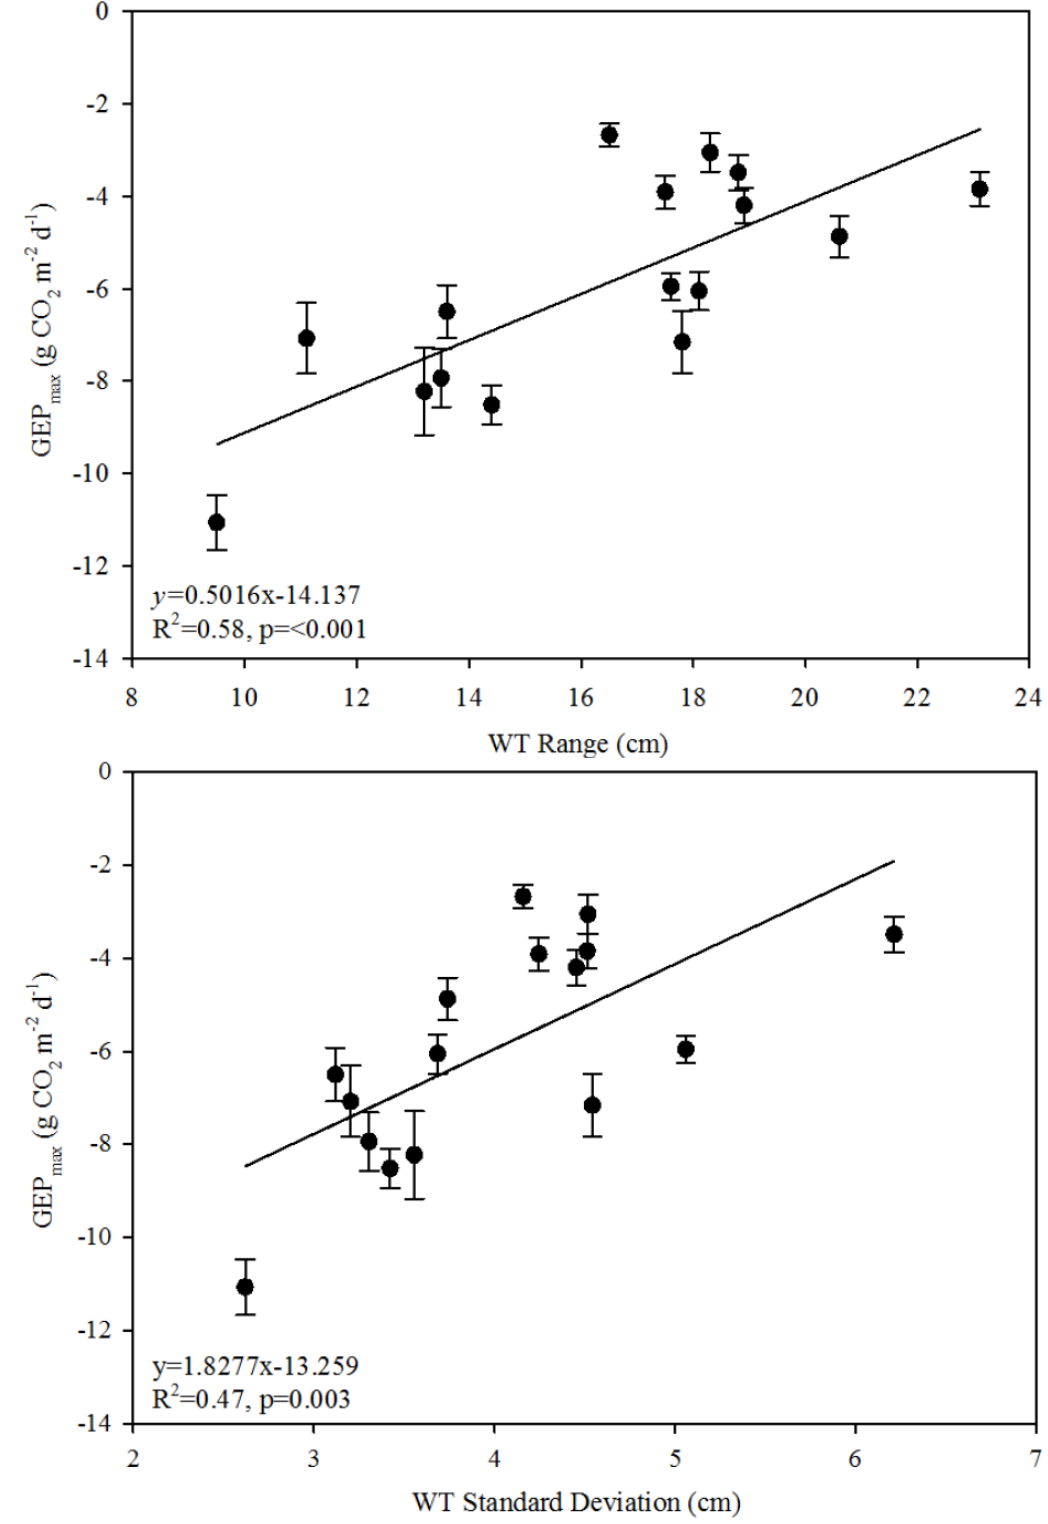
Figure 3. Regression between actively managed mean plot gross ecosystem photosynthesis when photon flux density of photosynthesis was greater than 1000 µmol m -2 s -1 (GEP maximum – minimum) and one standard deviation from the WT mean. Error bars show SE of GEP